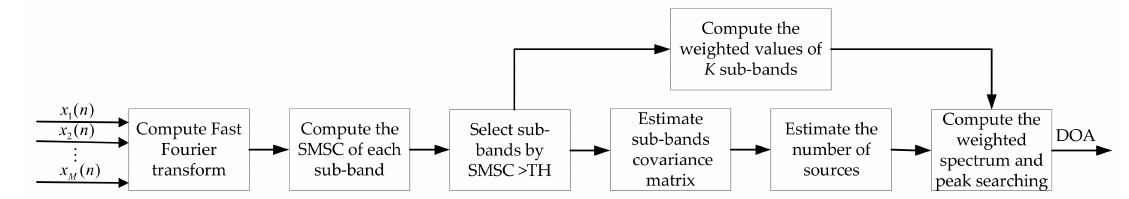
Figure 6. The block diagram of the weighted sub-band DOA estimation